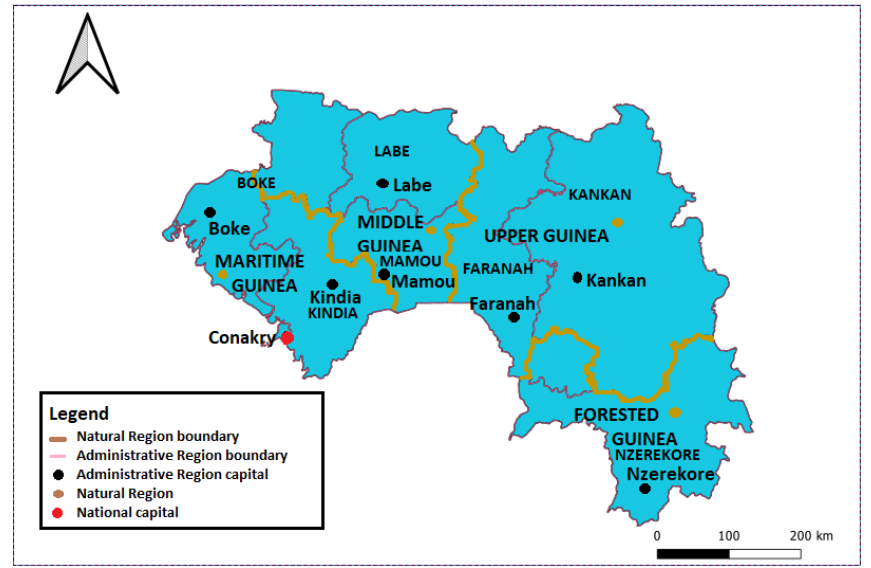
Figure A1. Guinea